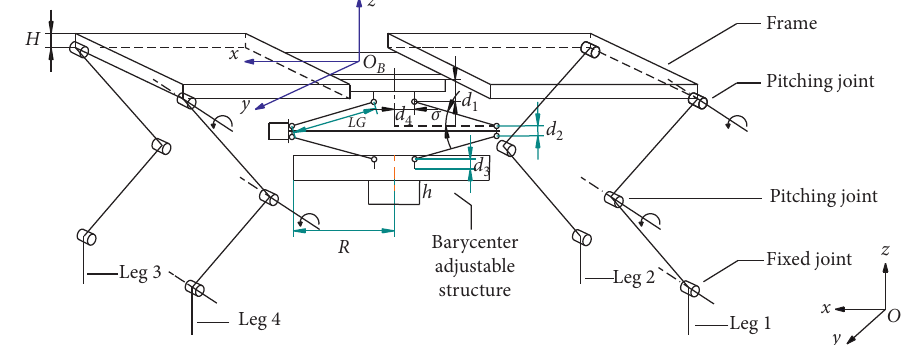
Figure 1: Sketch of forestry chassis with BAM.